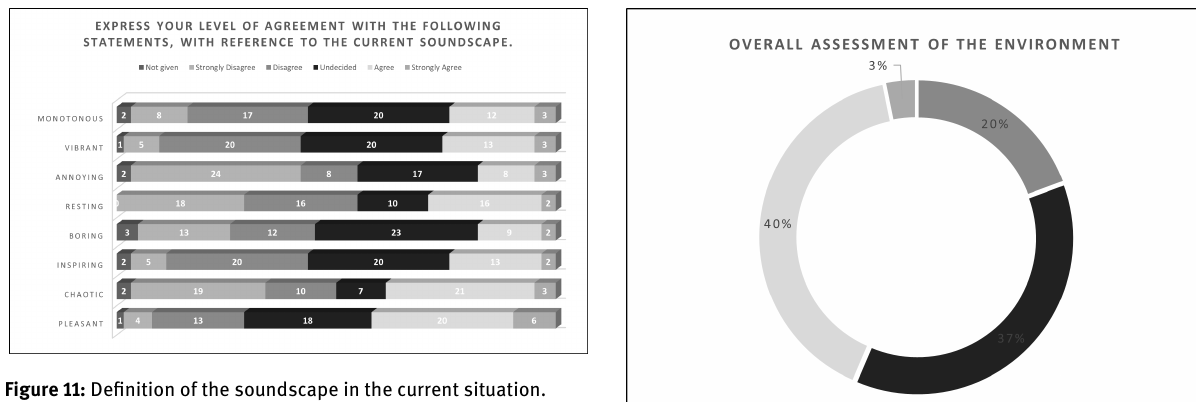
Figure 11: Definition of the soundscape in the current situation.